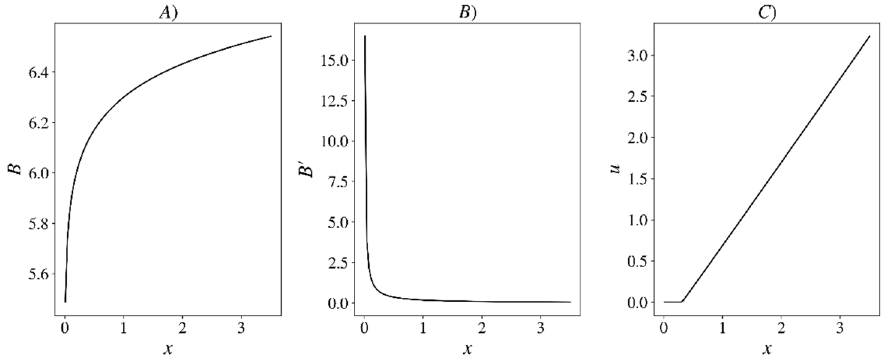
Figure 1. Fishery value function ( A ), internal price ( B ), and optimal catch ( C ) over the fish stock. Property 3. Optimal fishing u ( x ) is a continuous and non-decreasing function. For small x, we have u = 0 , and for large x, it strictly increases.